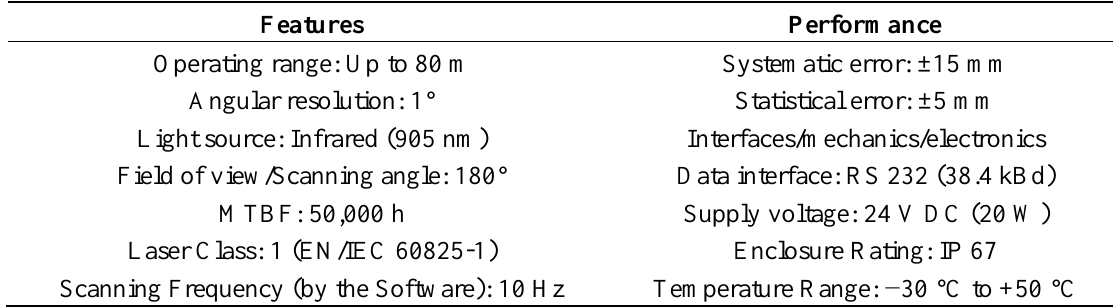
Table 1. LMS 221 technical data.